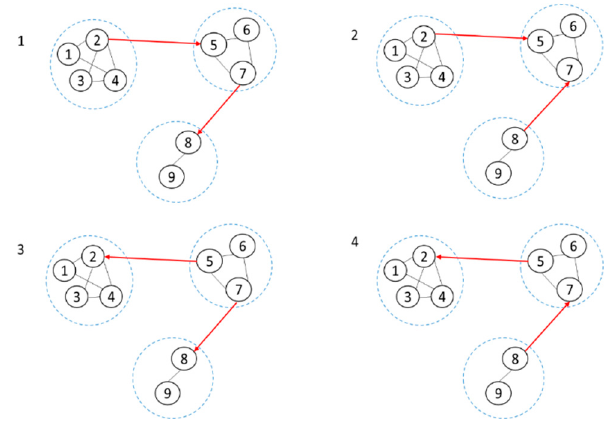
Figure 3. Four possible graph structures among all the blocks corresponding to Figure 2.